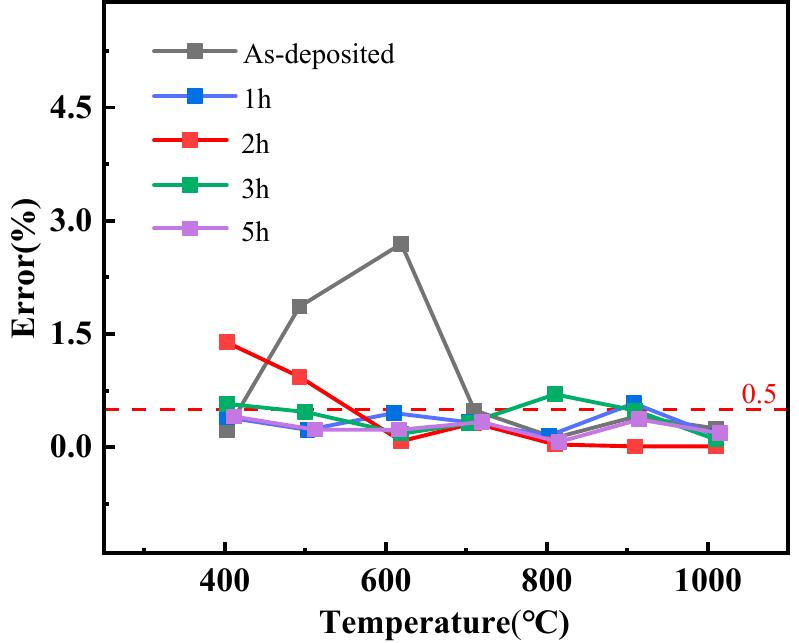
Figure 7. Errors of ITO/In 2 O 3 TFTCs annealed for different